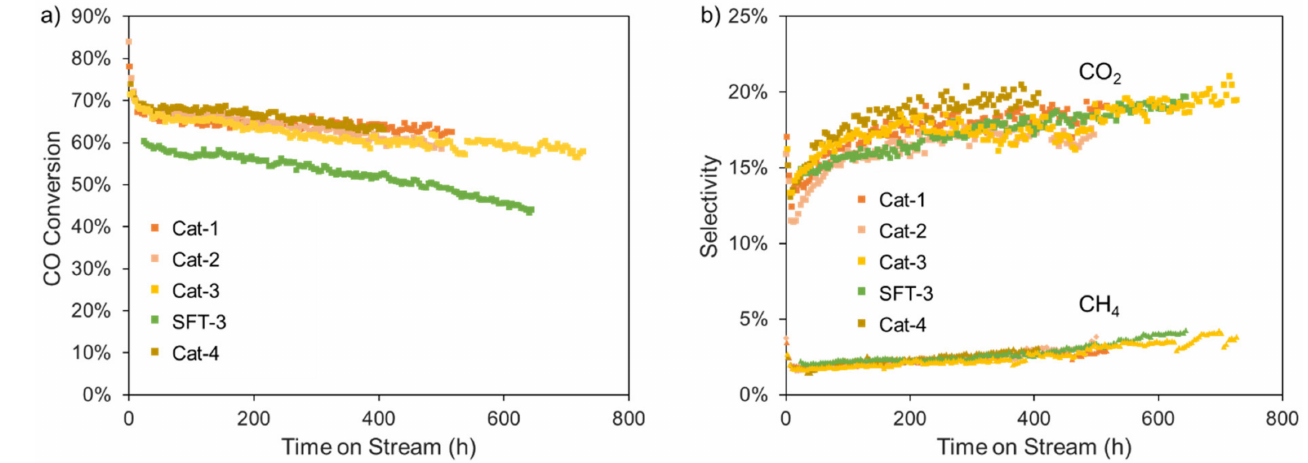
Figure 8. ( a ) CO conversion and ( b ) selectivity of Cat-1–4 and SFT-4.